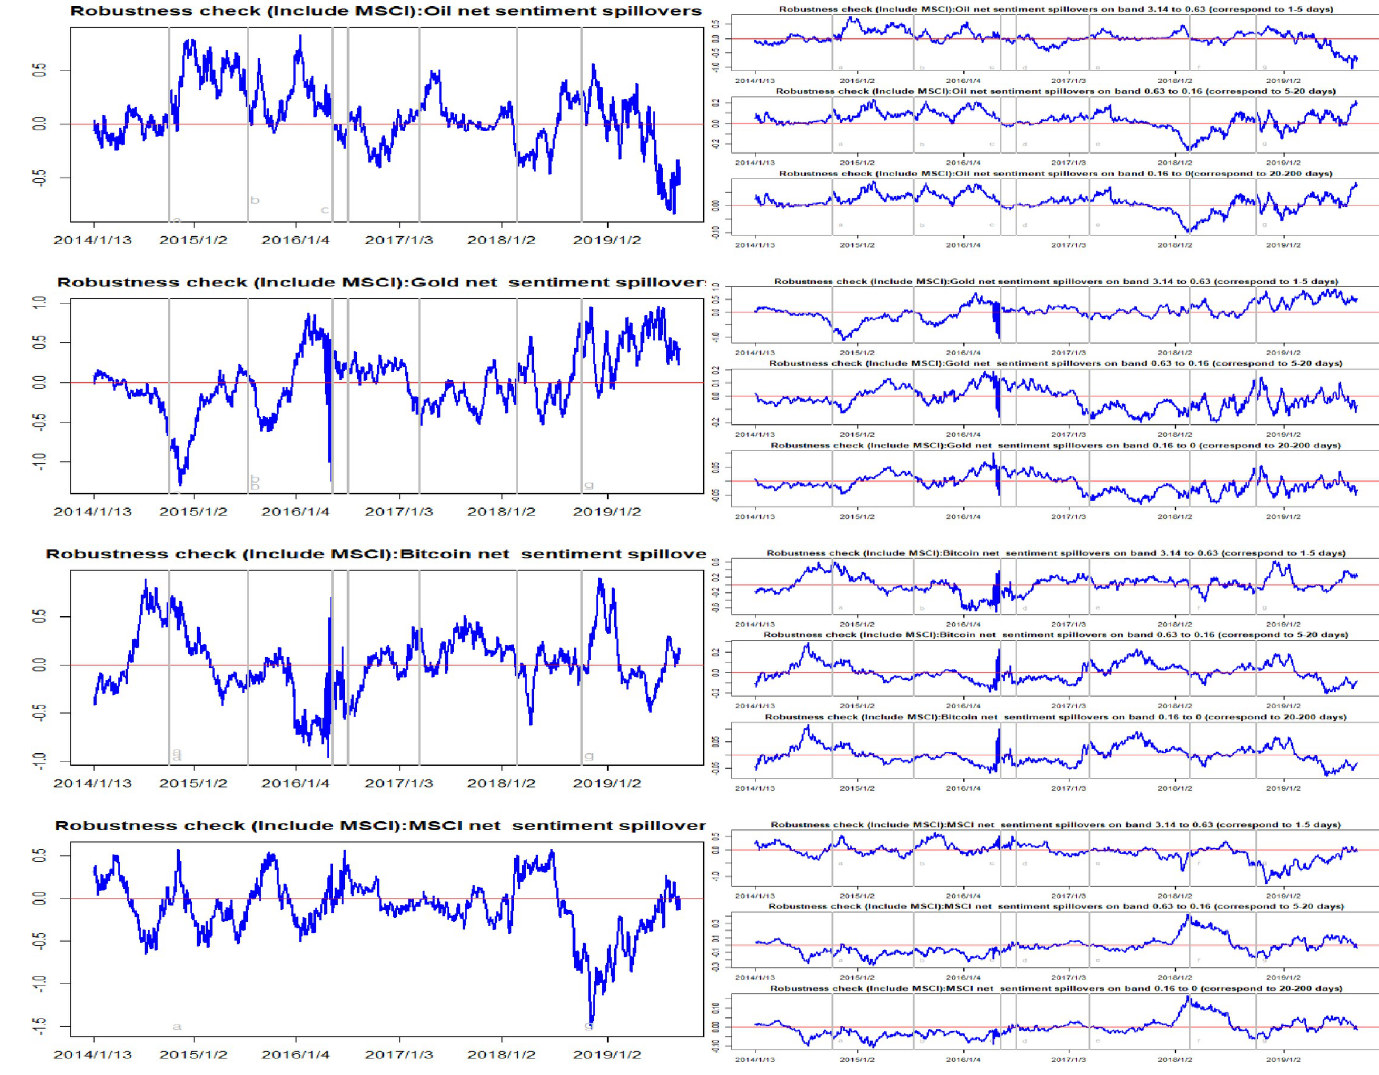
Fig 10. Robustness check (Include MSCI): Time-frequency dynamics of net sentiment spillovers for oil, gold, Bitcoin and MSCI. a, b, c, d, e, f, g respectively represent the seven events: the WTI oil price collapsed in October 2014, the black swan event in gold market occurred in July 2015, the sharp rise of bitcoin prices in May 2016, the Brexit event in July 2016, the expectations of a Federal Reserve rate hike in March 2017, the price of Bitcoin and gold fluctuating fall at the beginning of 2018, and the WTI oil price declines in August 2018.